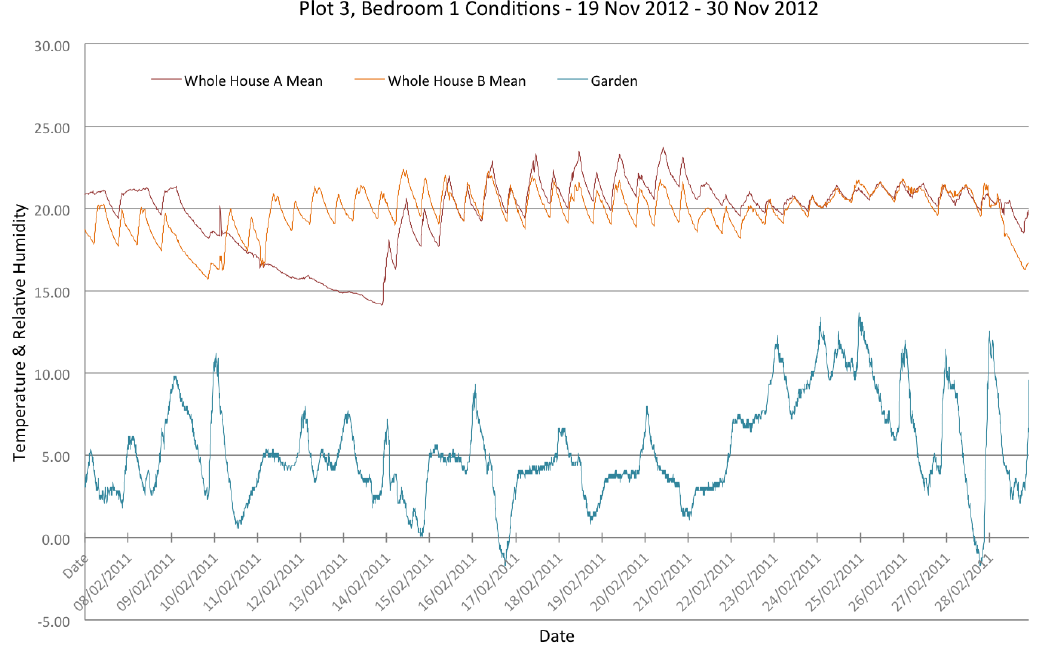
Figure 11. Pilot study, average temperatures Plot 1 and Plot